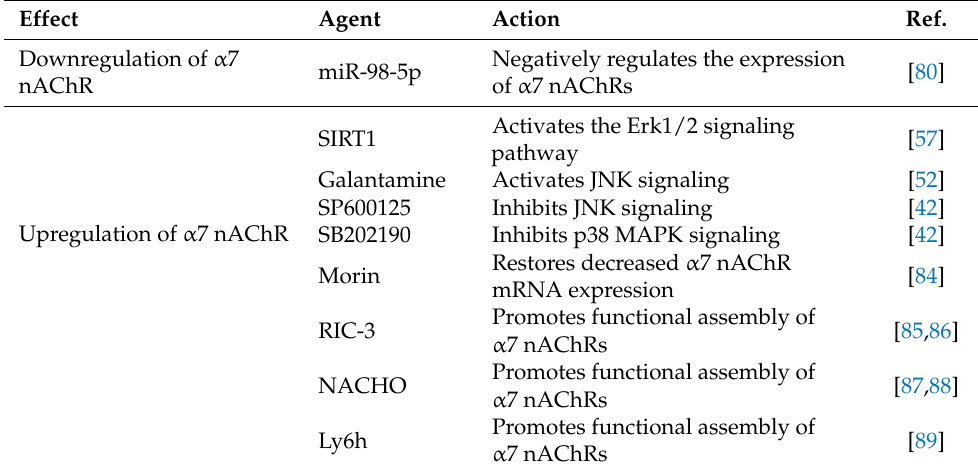
Table 2. Regulators of α 7 nAChR